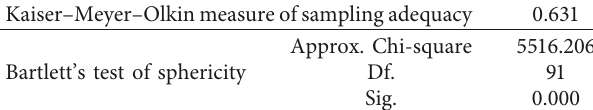
Table 3: KMO and Bartlett’s